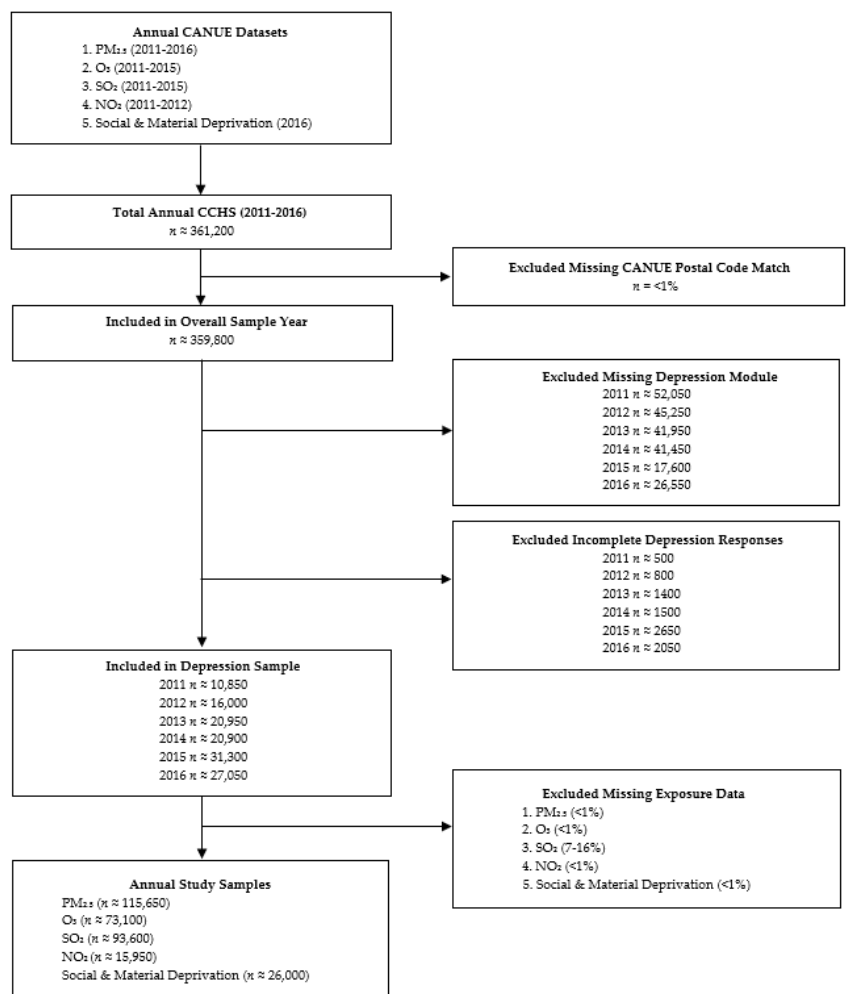
Figure A1. Flow chart of the annual sample sizes. Sample sizes are rounded to base 50 as per Statistics Canada guidelines and may not add up.